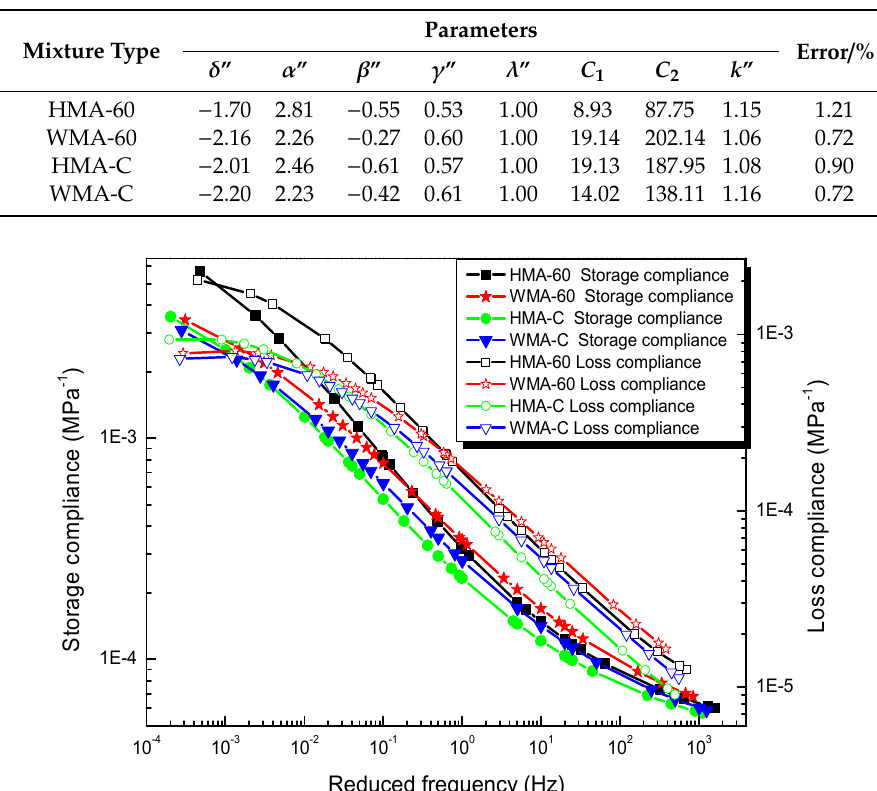
Table 6. GSM fitting parameters for storage compliance and loss compliance.